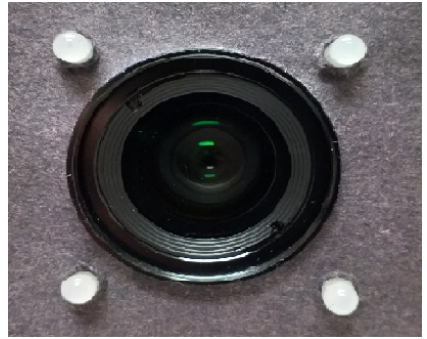
Figure 3. Hartmann screen. Figure 3. Hartmann